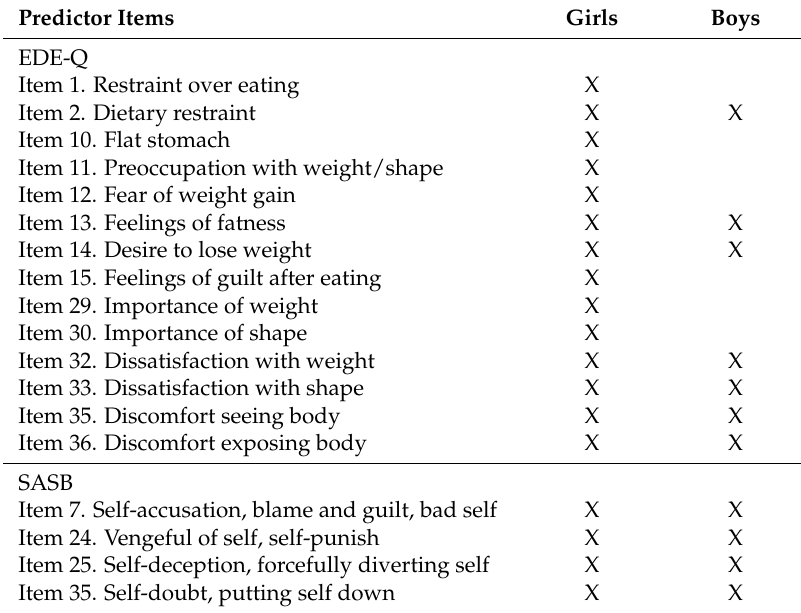
Table 1. Overview of items tested for associations with CE in girls and boys. Predictor Items Girls